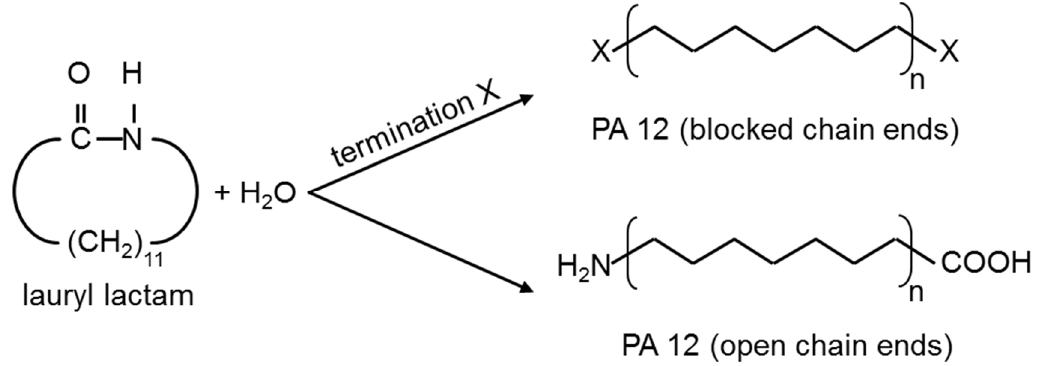
Figure 9. Polyaddition of lauryl lactam with or without end-group regulation.